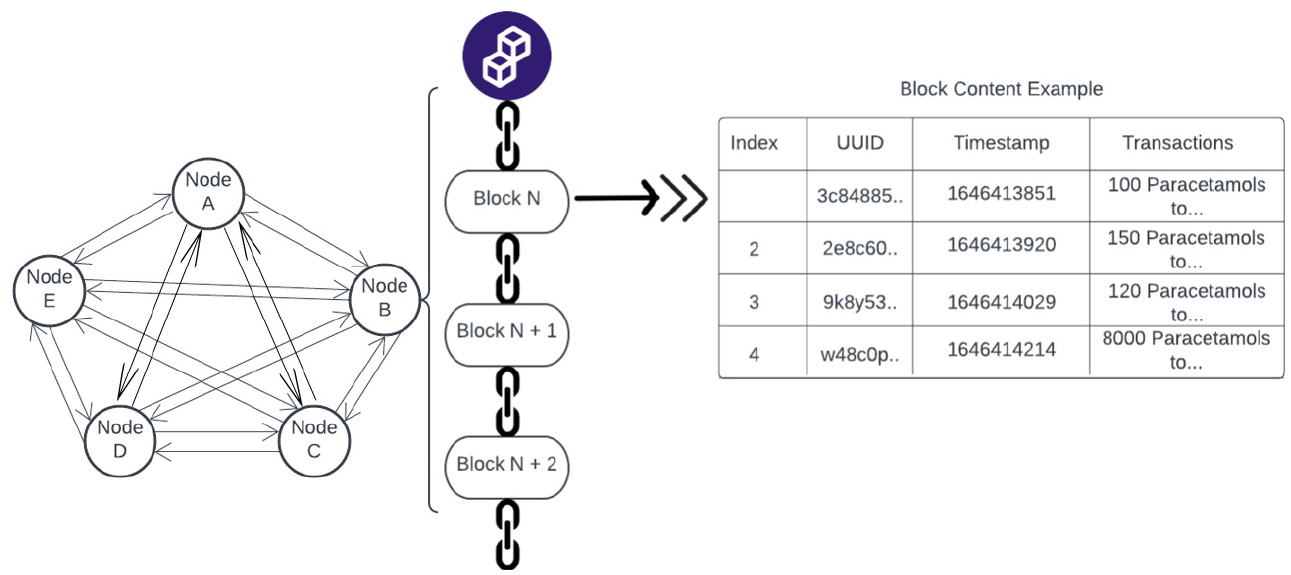
Figure 1. Example of blockchain components.